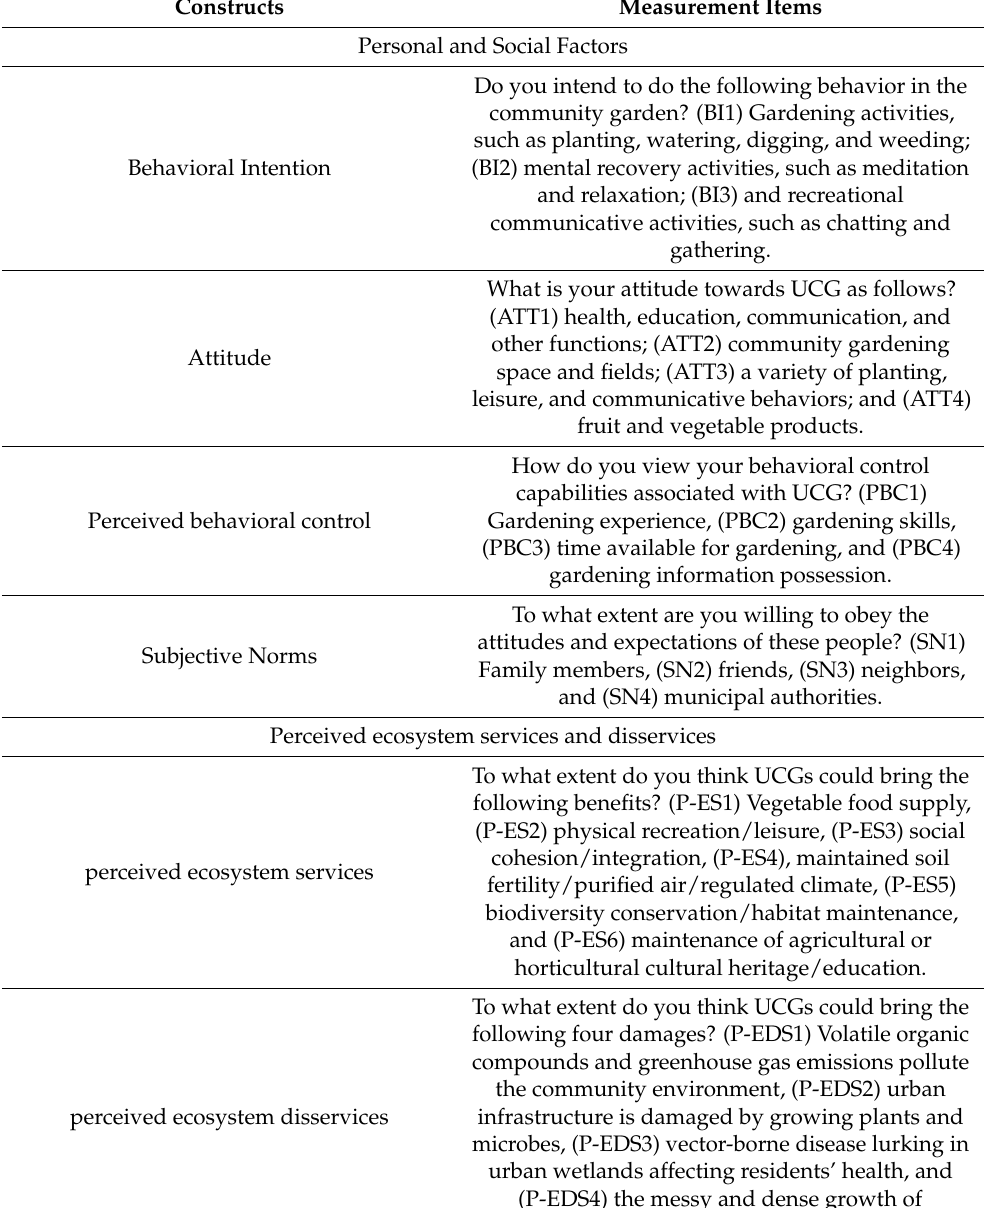
Table 3. Measurement items for the personal, social, and perceived ES/EDS